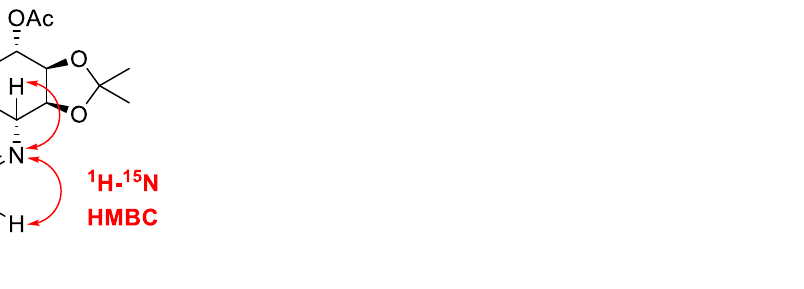
Figure 3. Structure of C-6 vinyl 26 and detected 1 H- 15 N-NMR correlations highlighted by red arrows .